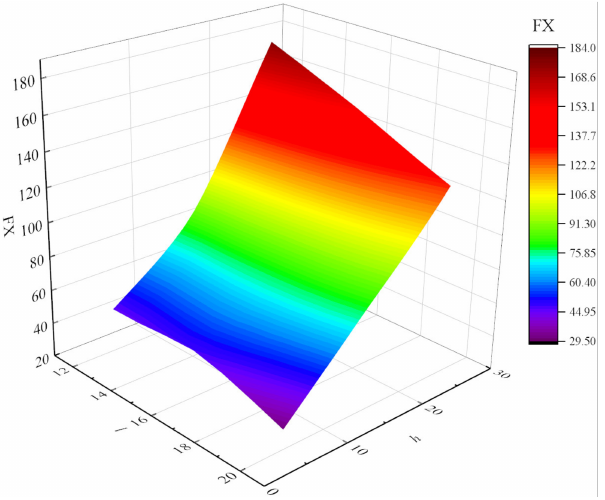
Figure 17. Effects of h and l on